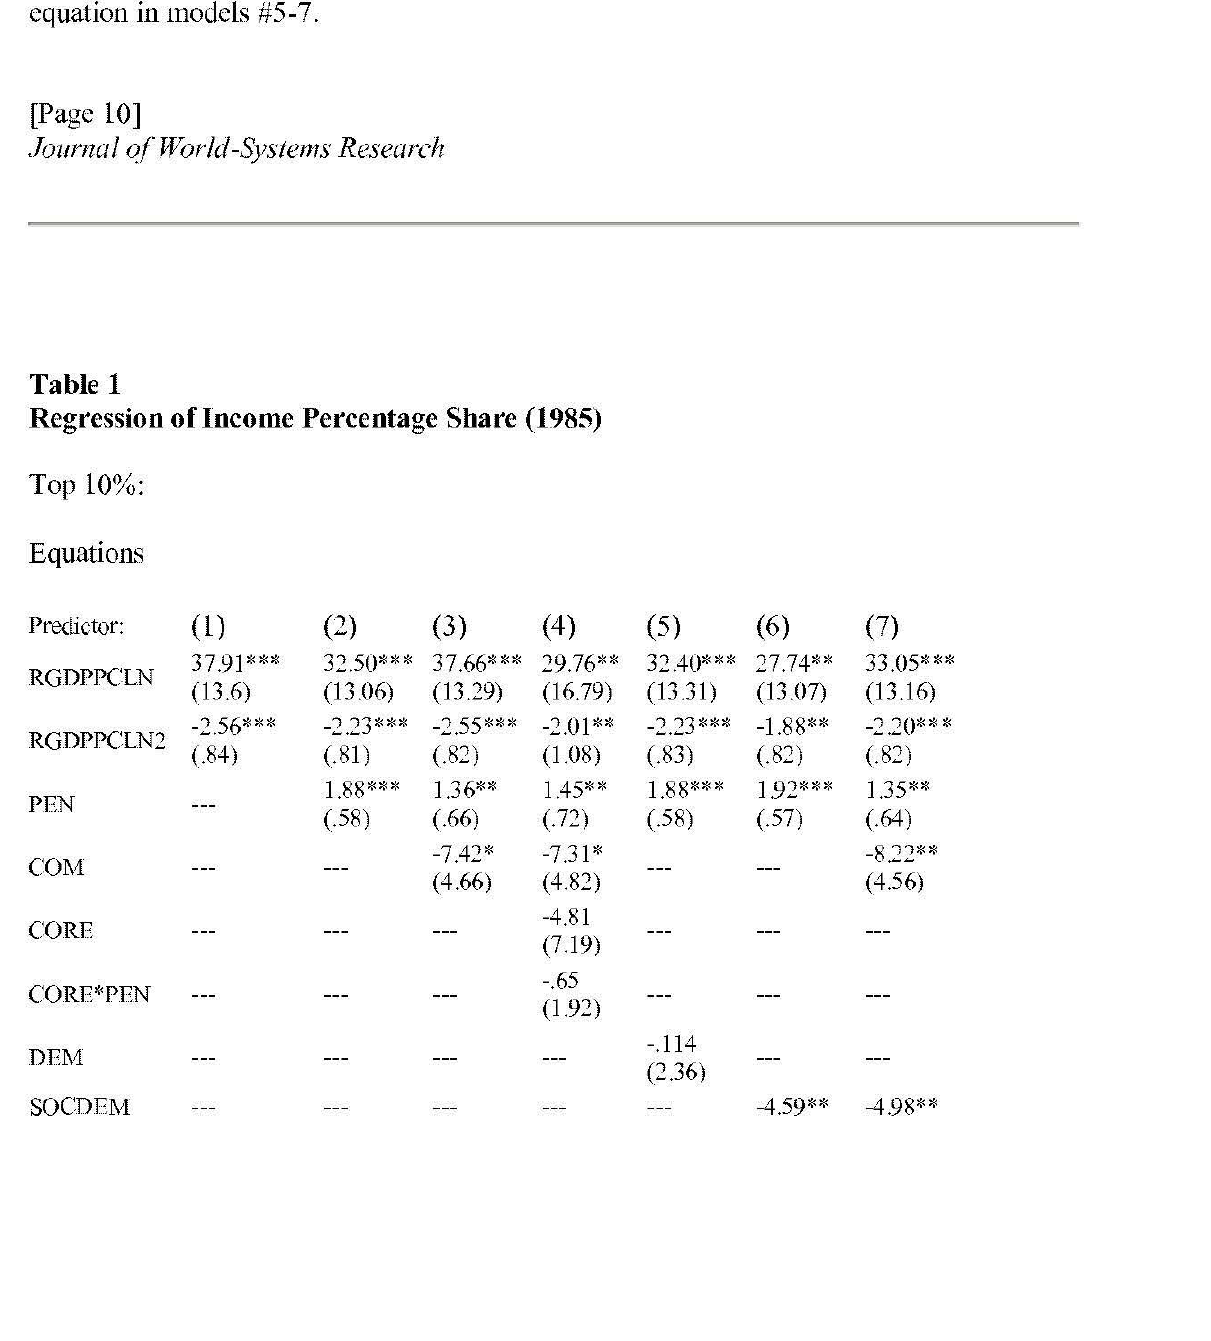
Regression of Income Percentage Share (1985) Top 10%